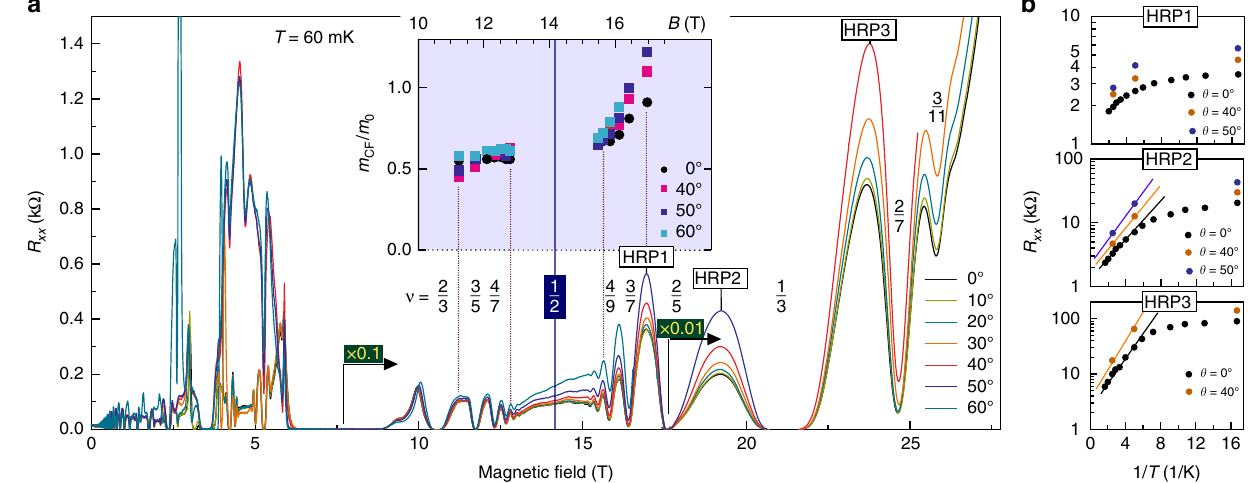
Fig. 3 Magnetotransport in tilted magnetic fi elds. a The resistance of high resistivity phases HRP1, HRP2, and HRP3 increases with the application of in-plane magnetic fi eld. The insulating phase shifts towards higher fi lling factors with increasing in-plane fi eld, as can be seen from the growing background around ν = 1/2. Inset: mass of composite fermions evaluated from temperature dependence of R xx oscillation amplitude. b Temperature dependence of high resistivity phases HRP1, HRP2, and HRP3 at several tilt the ν = 1/2 region with an increasing θ 32,33 , we may also suppose